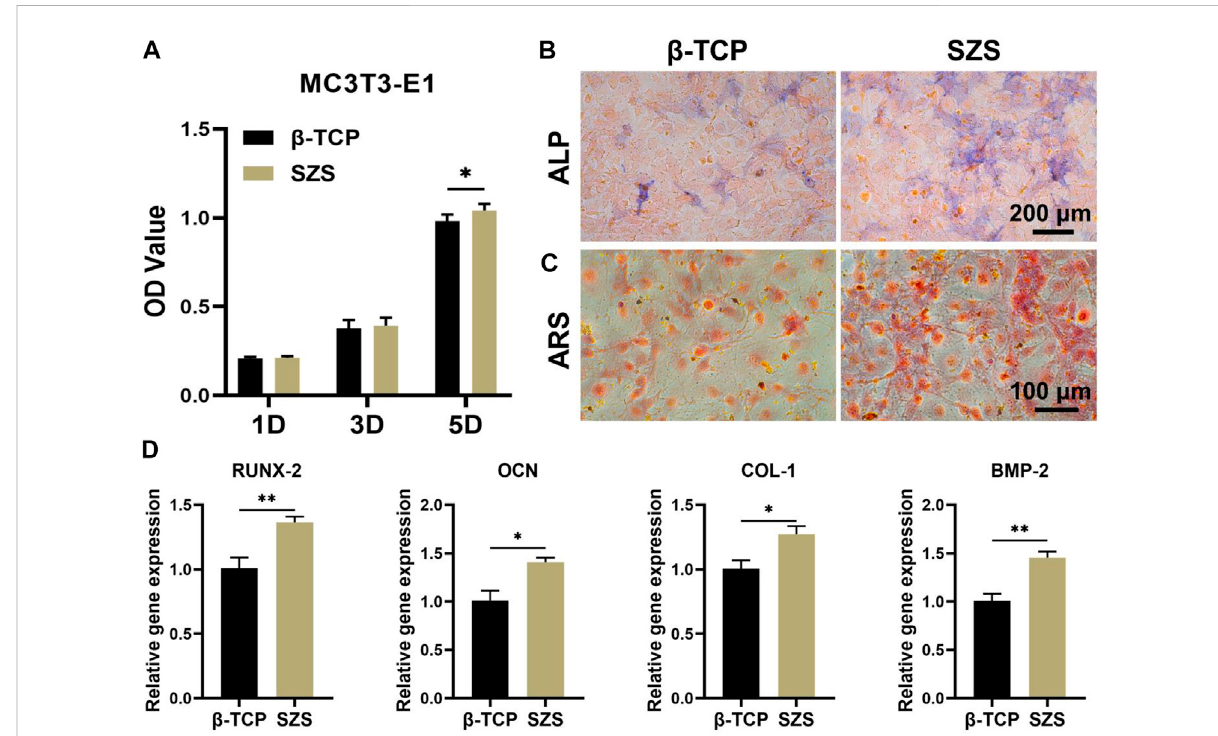
FIGURE 4 Effect of macrophage/scaffold conditional medium on MC3T3-E1 cells. (A) Cell proliferation on day 1, 3, and 5. ( n = 6). (B) Representative images of ALP staining after 7 days ’ culture. Blue color represents ALP. (C) Representative images of Alizarin red s (ARS) staining after 7 days ’ culture. Orange-red color represents calcium nodules. (D) The osteogenic genes (RUNX-2, OCN, COL-1, and BMP-2) expression in cells by q-PCR assessment after 7 days ’ culture. ( n = 4). * p < 0.05; ** p <